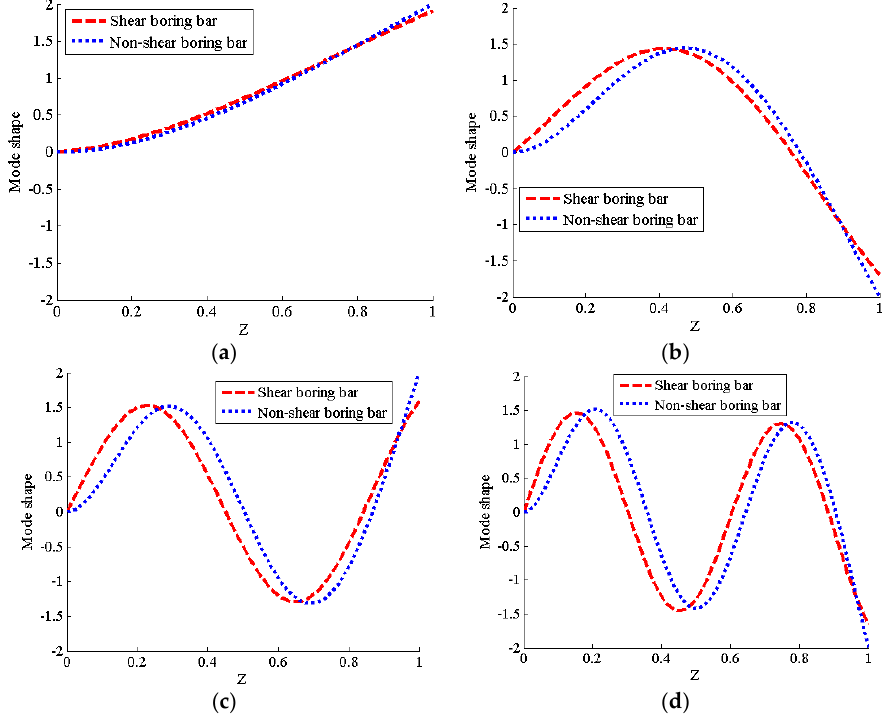
Figure 3. Four vibration mode shapes of the shear boring bar and non-shear boring bar. ( a ) First-order mode shape; ( b ) Second-order mode shape; ( c ) Third-order mode shape; ( d ) Fourth-order mode shape.